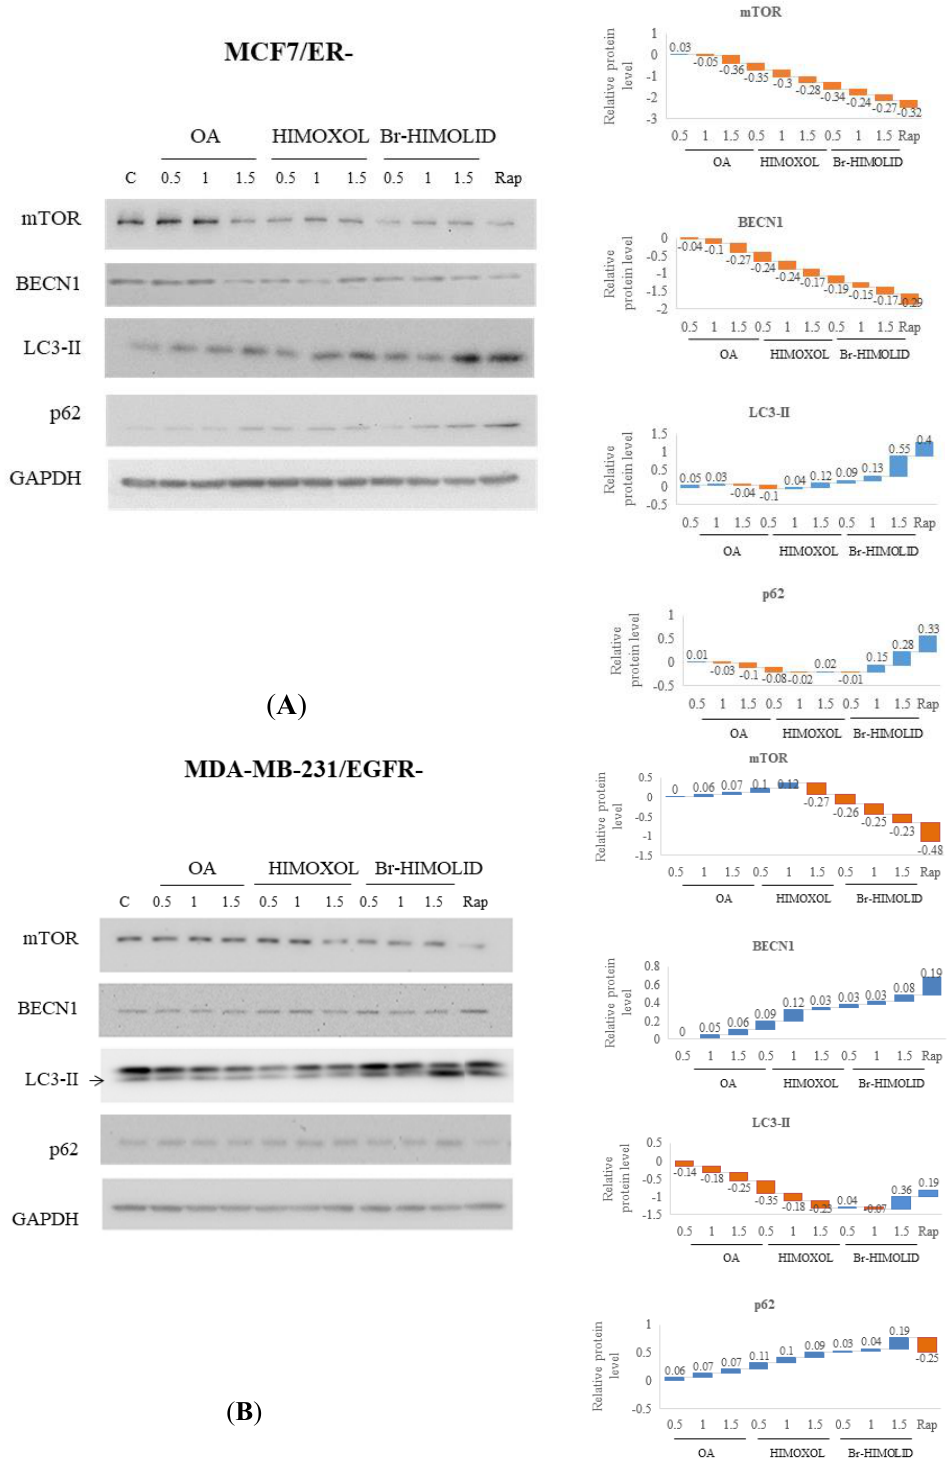
Figure 5. Evaluation of autophagy induction by OA and its derivatives in MCF7/ER − ( A ) and MDA-MB-231/EGFR − ( B ) breast cancer cells. Cells were treated with studied compounds, i.e., 0.5 × , 1 × , or 1.5 × IC 50 values for 24 h. Rapamycin (Rap, 100 nM) was used as a positive control. The diagrams present a semiquantitative assessment of target protein levels relative (fold change) to control, untreated